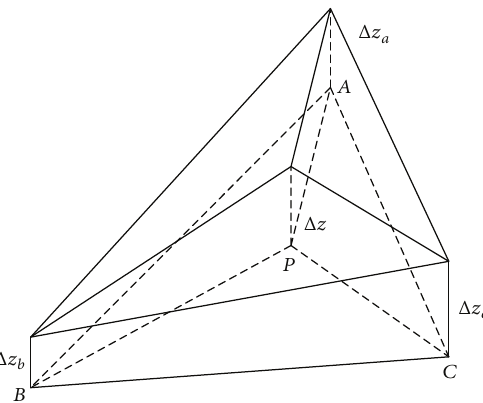
Figure 3: A triangular element 𝐴𝐵𝐶 in FEM analysis